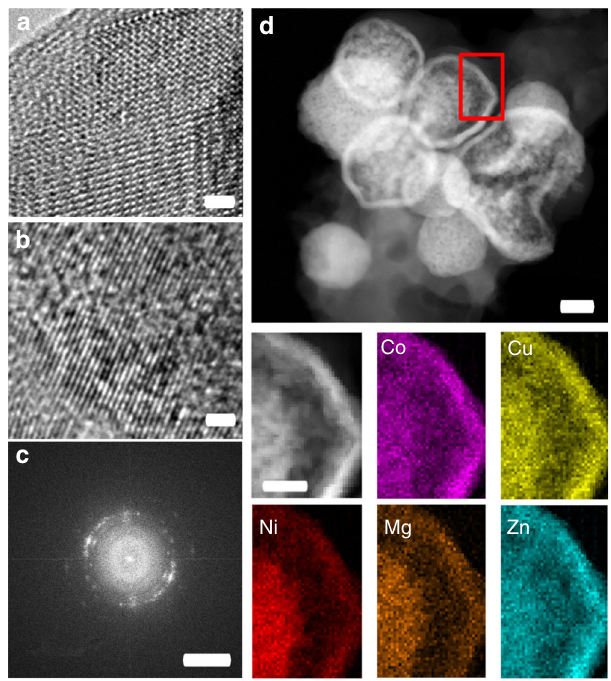
Fig. 4 HRTEM and EDX analysis of the active material. a , b HRTEM images of the as-prepared and cycled TM-HEO, respectively. The crystallites in b are substantially smaller and do not show order over longer distances. The lattice fringes in b are not completely straight, but show a small divergence from the original axis. Nevertheless, the small regions with dimensions on the order of a few nanometers exhibit lattice fringes oriented in a speci fi c direction, likely due to the former long-range order, which is partially lost during the conversion reaction. c FFT of a HRTEM image of a few crystallites. The arcs in the FFT correspond to the cubic rock-salt structure, but they indicate a certain texture. The lattice fringes are discontinuous between different crystallites; however, the misorientation is small, caused probably by large amounts of defects or low angle boundaries. d STEM image showing the spheres consist of small particles and the respective elemental maps of the area indicated by the red rectangle. No apparent segregation occurs at the length scale of aggregates of nanoparticles. The scalebars in a and b correspond to 1 nm, in c to 5 1/ nm, in d to 200 nm and for the compared EDX analysis to 60